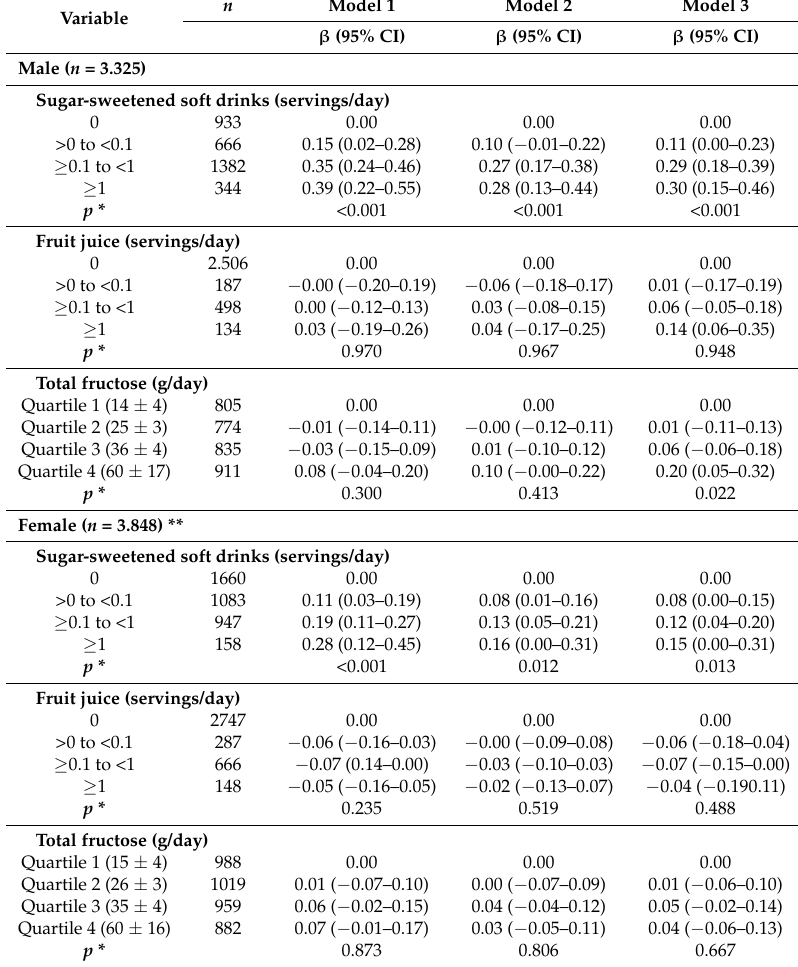
Table 4. Linear regression coefficients (95% CIs) between serum uric acid levels and sugar-sweetened soft drinks intake, fruit juice intake and total fructose. ELSA-Brasil, 2008–2010. n Model Variable